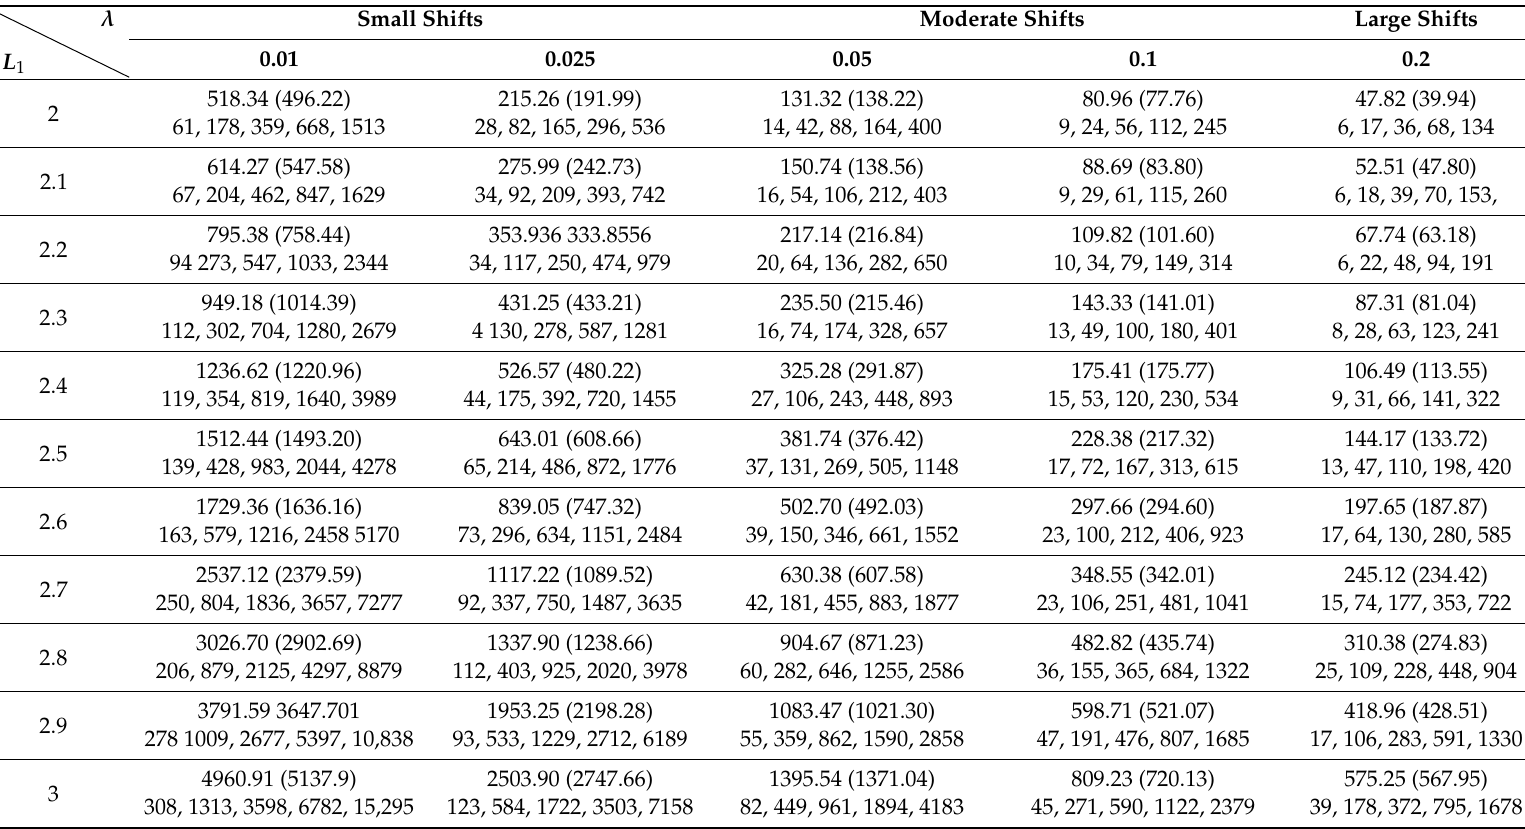
Table 1. In-control (IC) run length (RL) profiles of the proposed chart when m = 3, n =